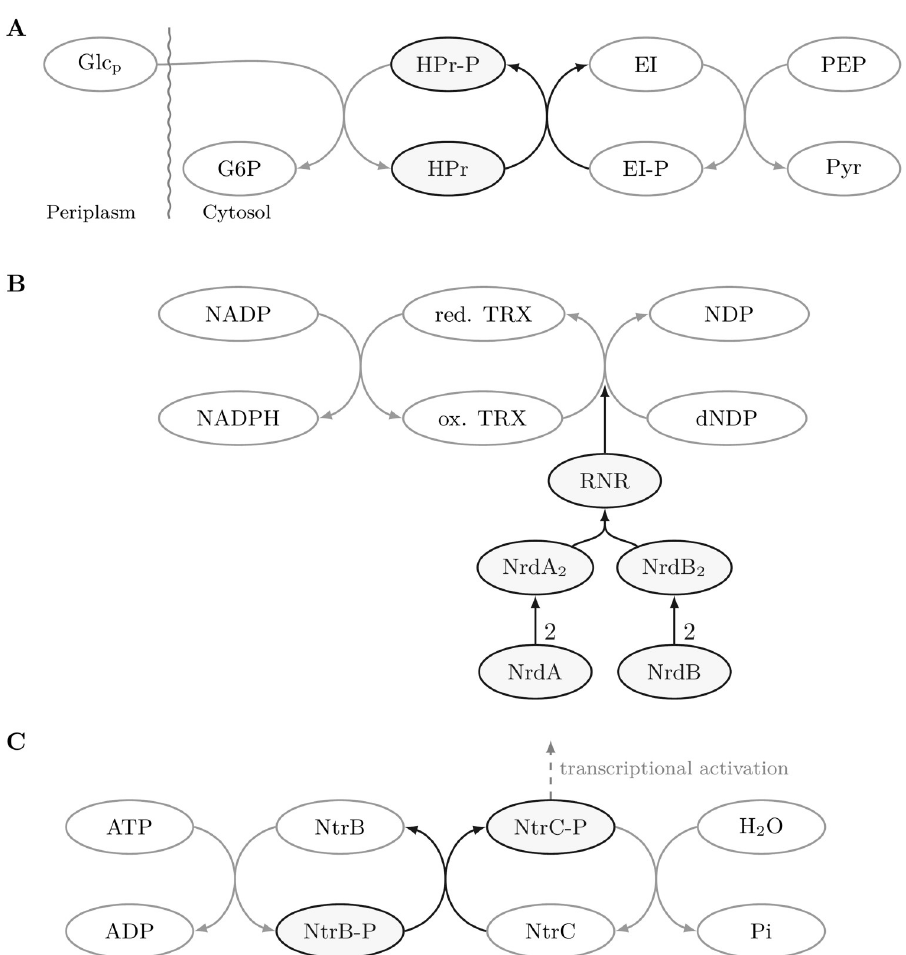
Fig 7. Classical representation of the three major interface systems of the integrative E. coli network. The systems shown here are the phosphoenolpyruvate-dependent sugar phosphotransferase system (PTS, A ), the ribonucleotide reducing system (RNR system, B ) and the nitrogen regulation two-component signal transduction system (NtrBC system, C ). The edges represent biochemical reactions and the vertices denote the involved compounds and proteins. The reactions and proteins highlighted in dark blue are the most abundant vertices determining nearly half of the traversing paths (Table E in S1 Text).